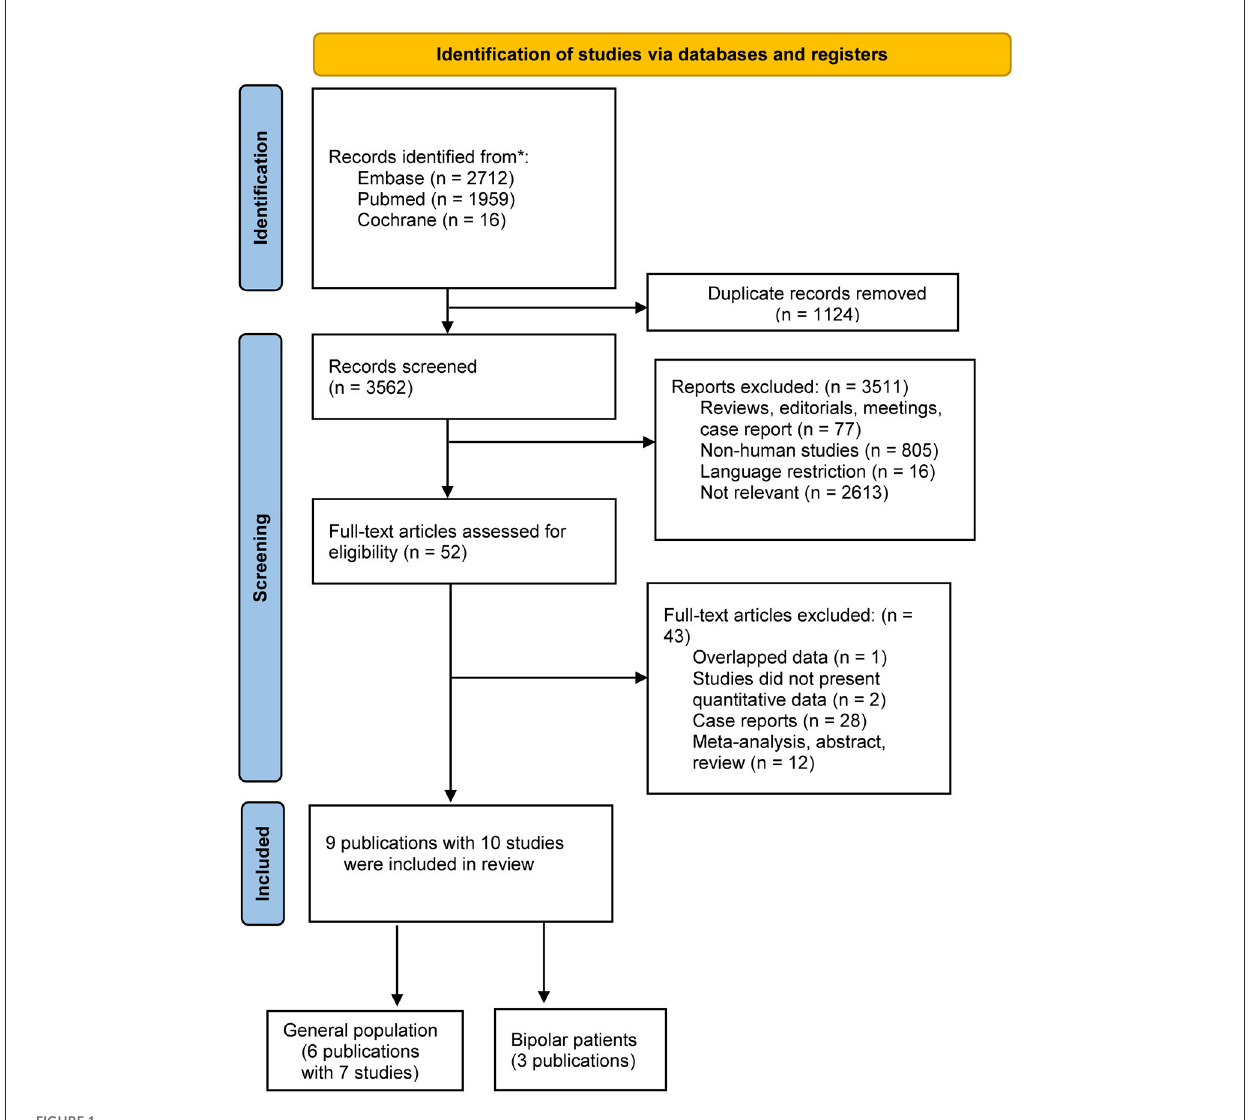
FIGURE1 Flow chart of the search process and study selection.